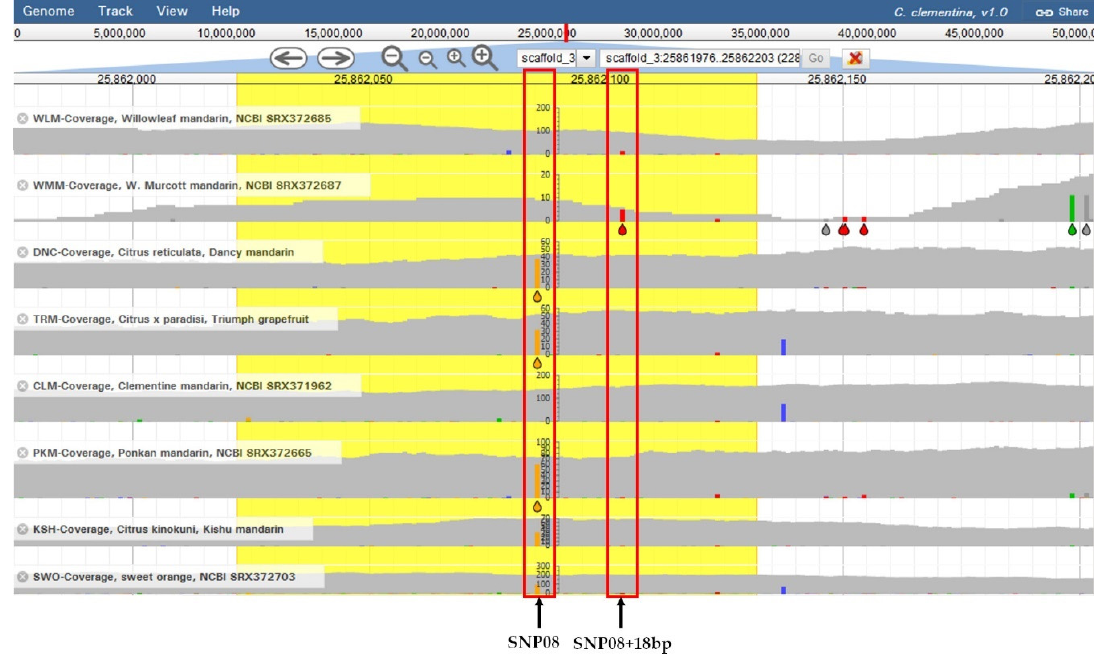
Figure 2. Genome browser showing the alignment of the sequence flanking the SNP08 and the additional SNP (SNP08+18bp) in resequenced genomes of Willowleaf (synonym of Avana), W. Murcott (synonym of Afourer), Dancy, Triumph grapefruit, Clementine, Ponkan, Seedless Kishu, and sweet orange aligned using the C. clementina genome as reference (retrieved from the citrus genome database—www.citrusgenomedb.org). The presence of different variant allele frequencies is clear at the position SNP08+18bp, particularly in Willowleaf and Ponkan mandarins, probably due to misaligned short reads not correctly assigned to other duplicated regions. Moreover, the susceptible Dancy has a small percentage of Ts at the SNP08.